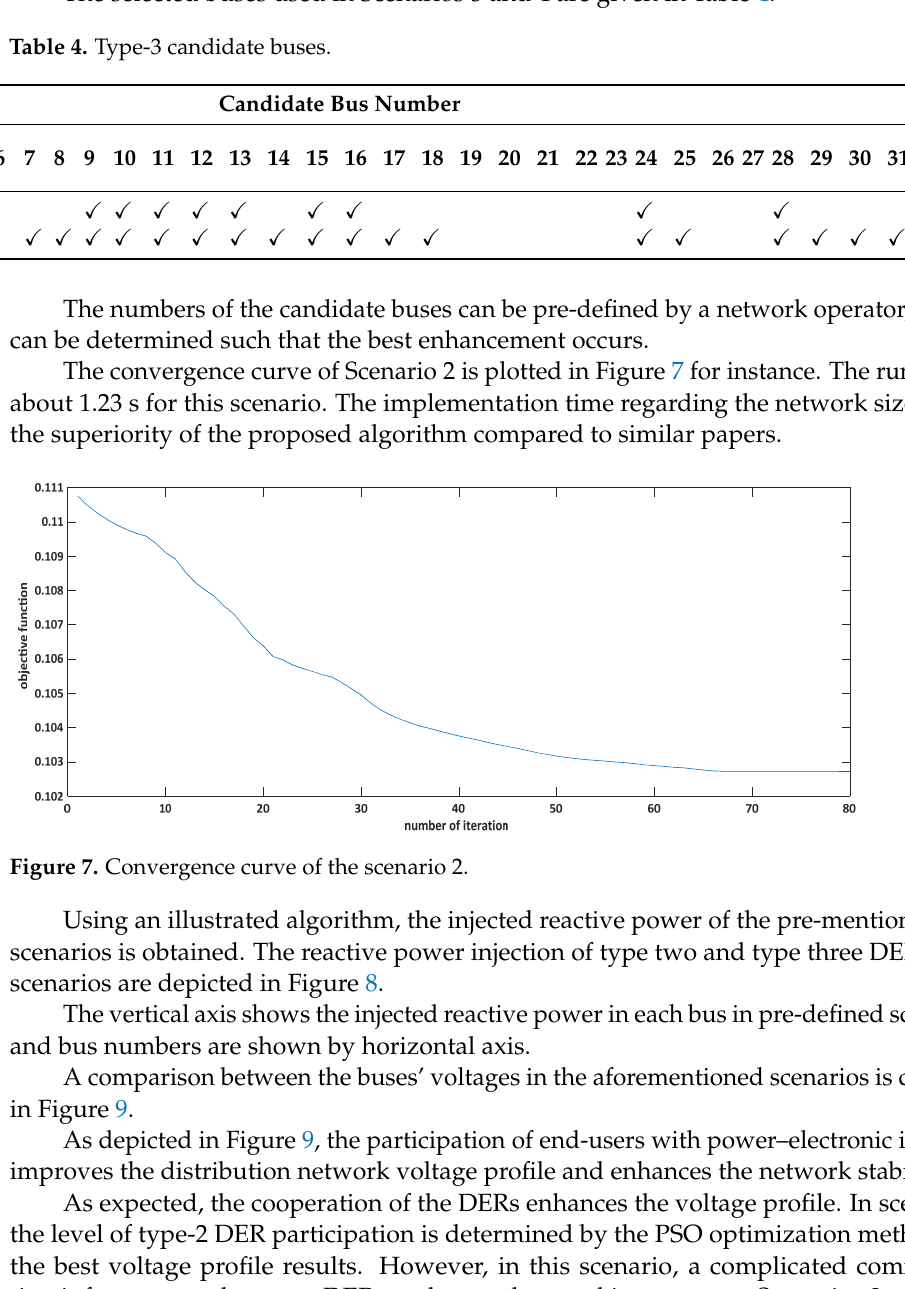
Figure 8. Reactive power injections of